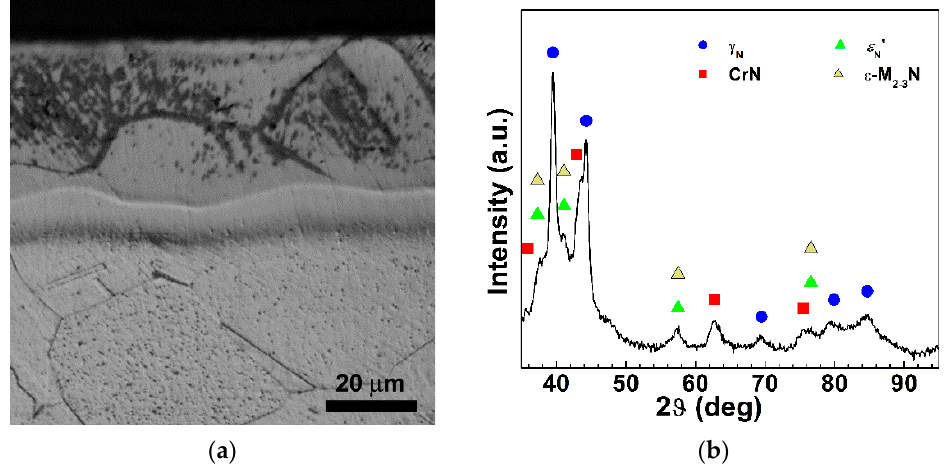
Figure 1. Micrograph ( a ) and X-ray diffraction pattern ( b ) of a sample nitrided at 400 °C, 500 Pa, for 3 h, using a gas mixture of 80 vol.% N 2 + 20 vol.% H 2 .